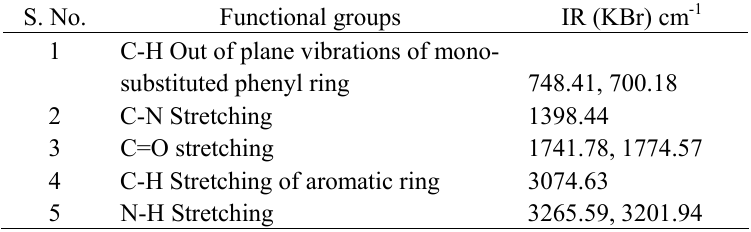
Table 2. IR Spectral data of phenytoin